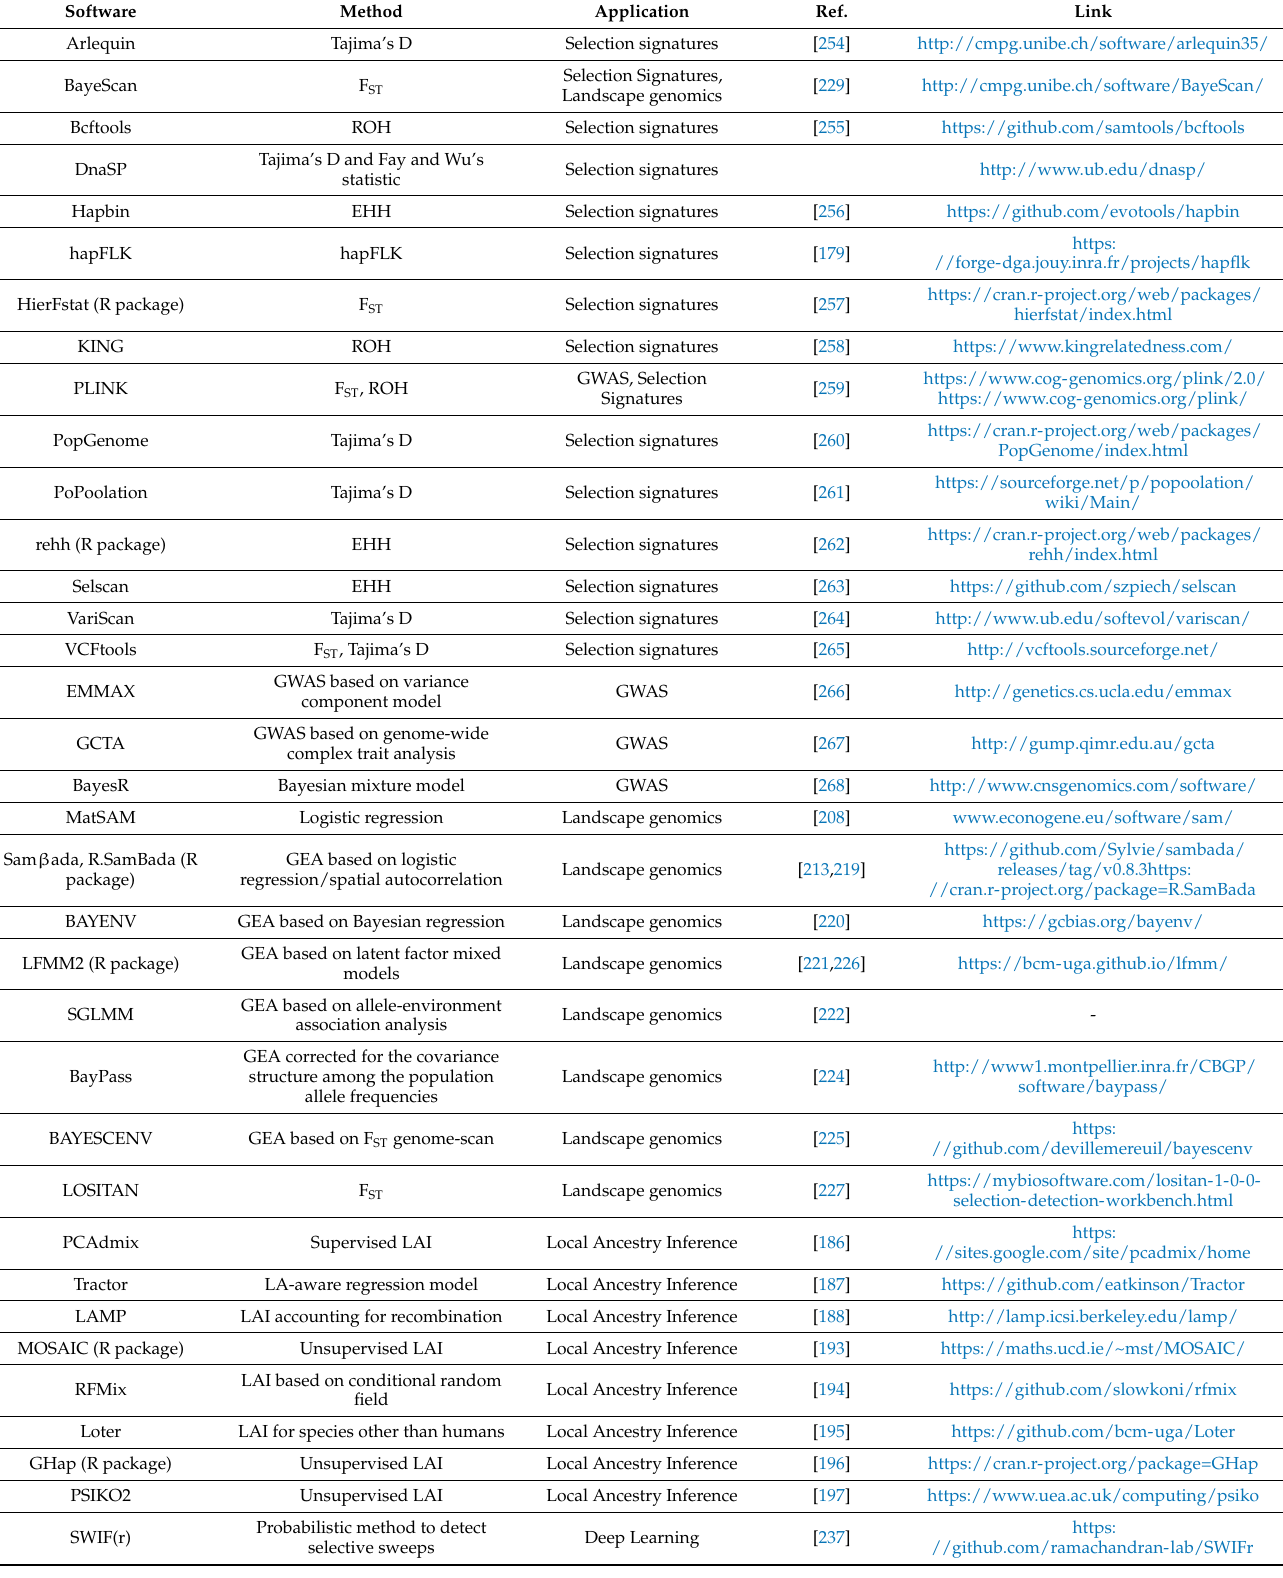
Table 1. Software for genome-wide